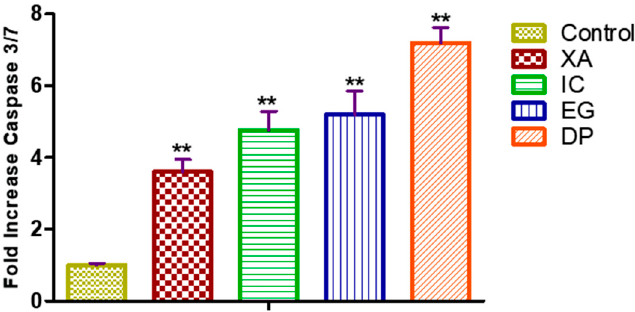
Figure 7. Enzymatic activity of caspase 3/7 on HeLla cells and after fold increase in activity after 24 h treatment of with IC 50 of the four studied plant extracts XA, IC, EG and DP. All data expressed as mean ± standard deviation (SD) at a significance level of p < 0.05 and indicated by **.